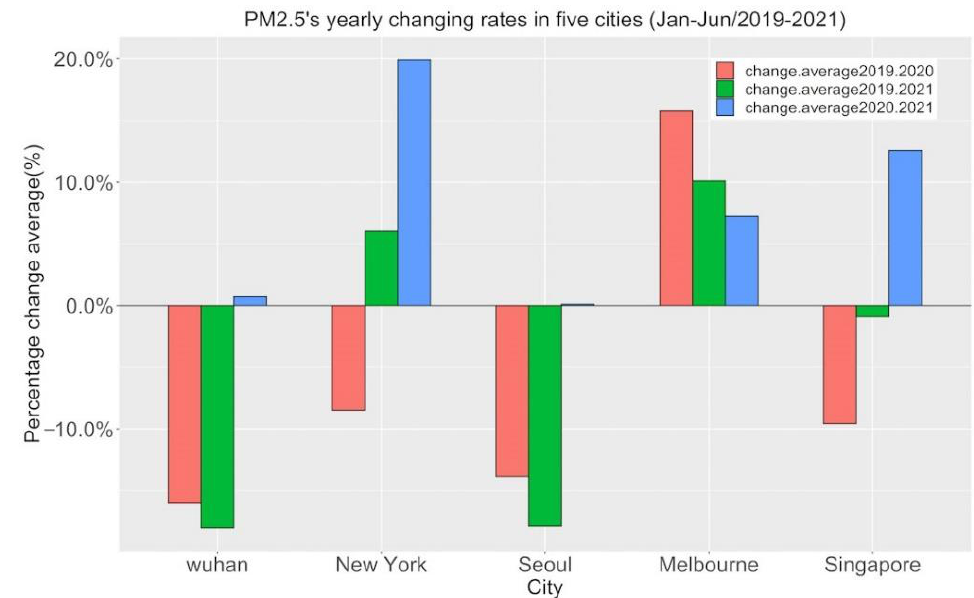
Figure 9. Yearly PM2.5 yearly changing rates in five cities (Jan – Jun/2019 – 2021).